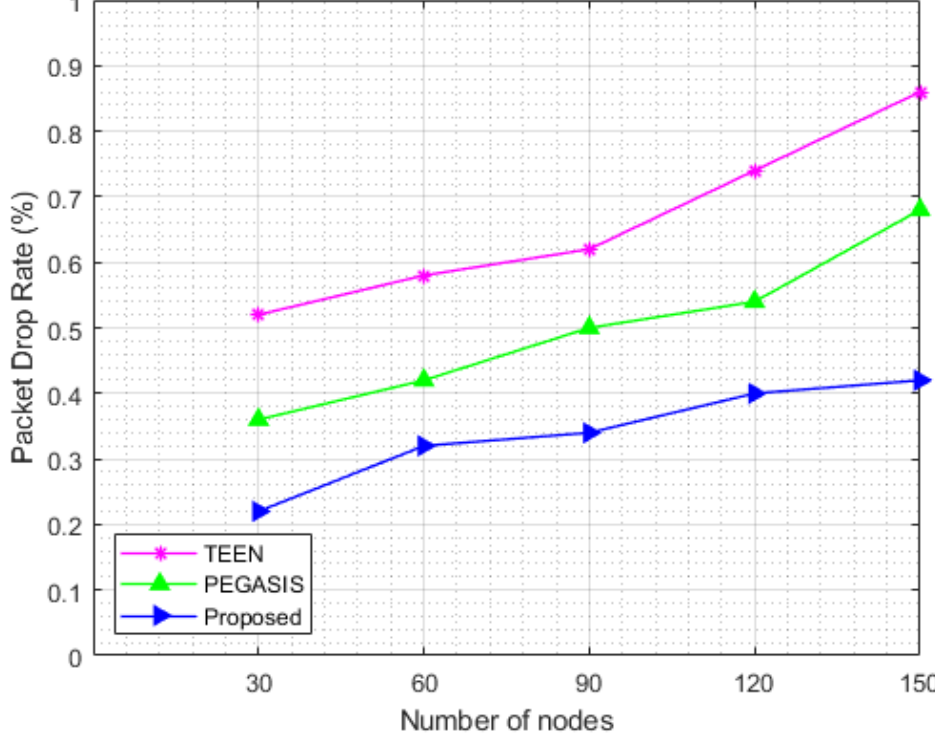
Figure 15. Number of nodes vs. packet drop ratio with 150 nodes.